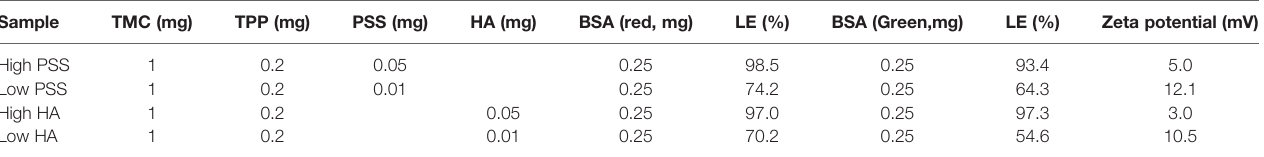
TABLE 2 | LbL NP composition and encapsulation and loading ef fi ciency for each of the vaccine candidates. Sample